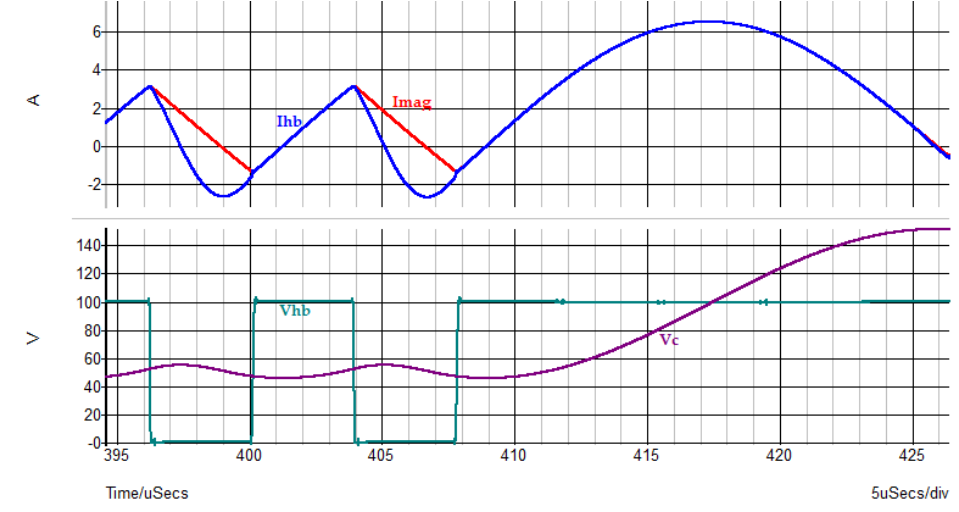
Figure 7. Primary waveforms over time with long charge time.